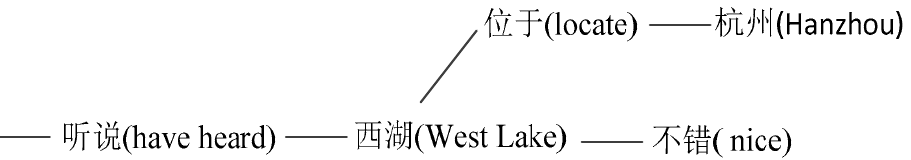
Figure 6. A sentence tree example. The triple with “West Lake” in this sentence tree is: “West Lake”—“locate”—“Hangzhou”. However, in fact, we are talking about the West Lake in Fuzhou.